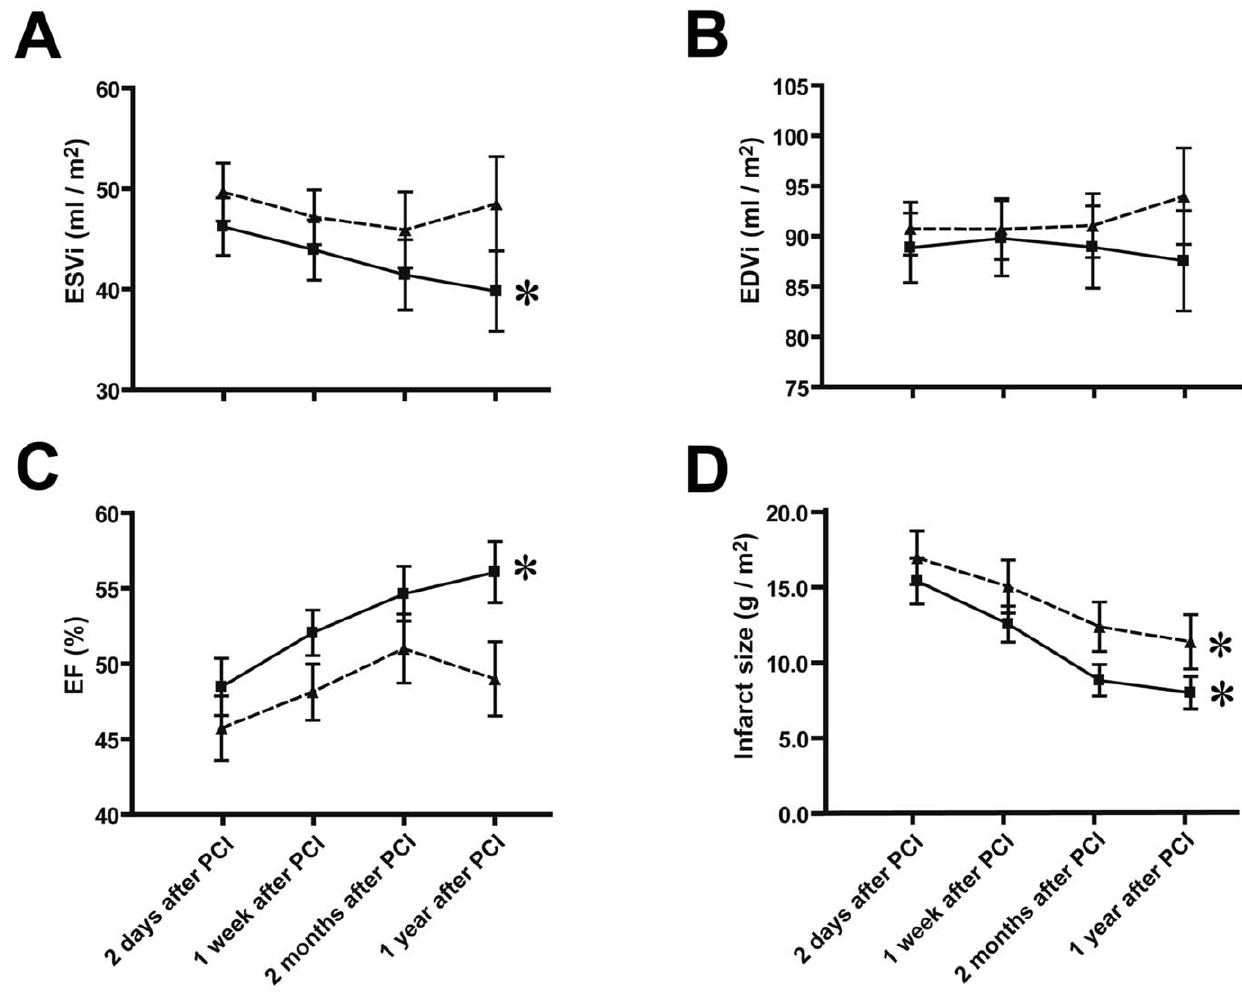
Figure 9. Serial assessments of left ventricular volumes and infarct size in patients stratified according to s-CTGF levels after MI. Panels demonstrating end-systolic volume index (ESVi) (A), end-diastolic volume index (EDVi) (B), ejection fraction (EF) (C) and infarct size (D) determined by CMR at successive time points from 2 days to 1 year after PCI in patients who responded with increase in s-CTGF levels after MI ( & ; n=21) compared with those in whom s-CTGF levels remained unaltered or decreased after MI ( m ; n=21). Values are mean 6 SEM. * P , 0.01 for intra- group comparisons.